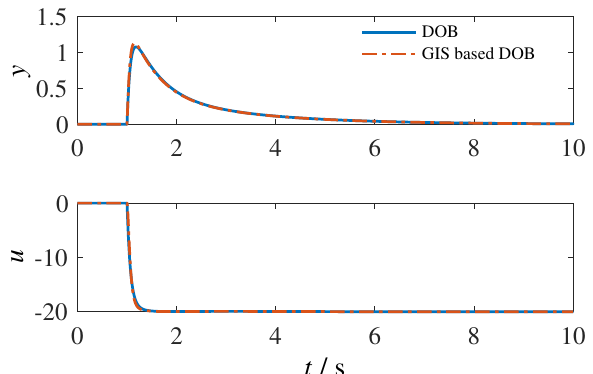
Figure 7. The curves of response y and control output u with a step external disturbance for Example 2 under DOBC and GIS-based